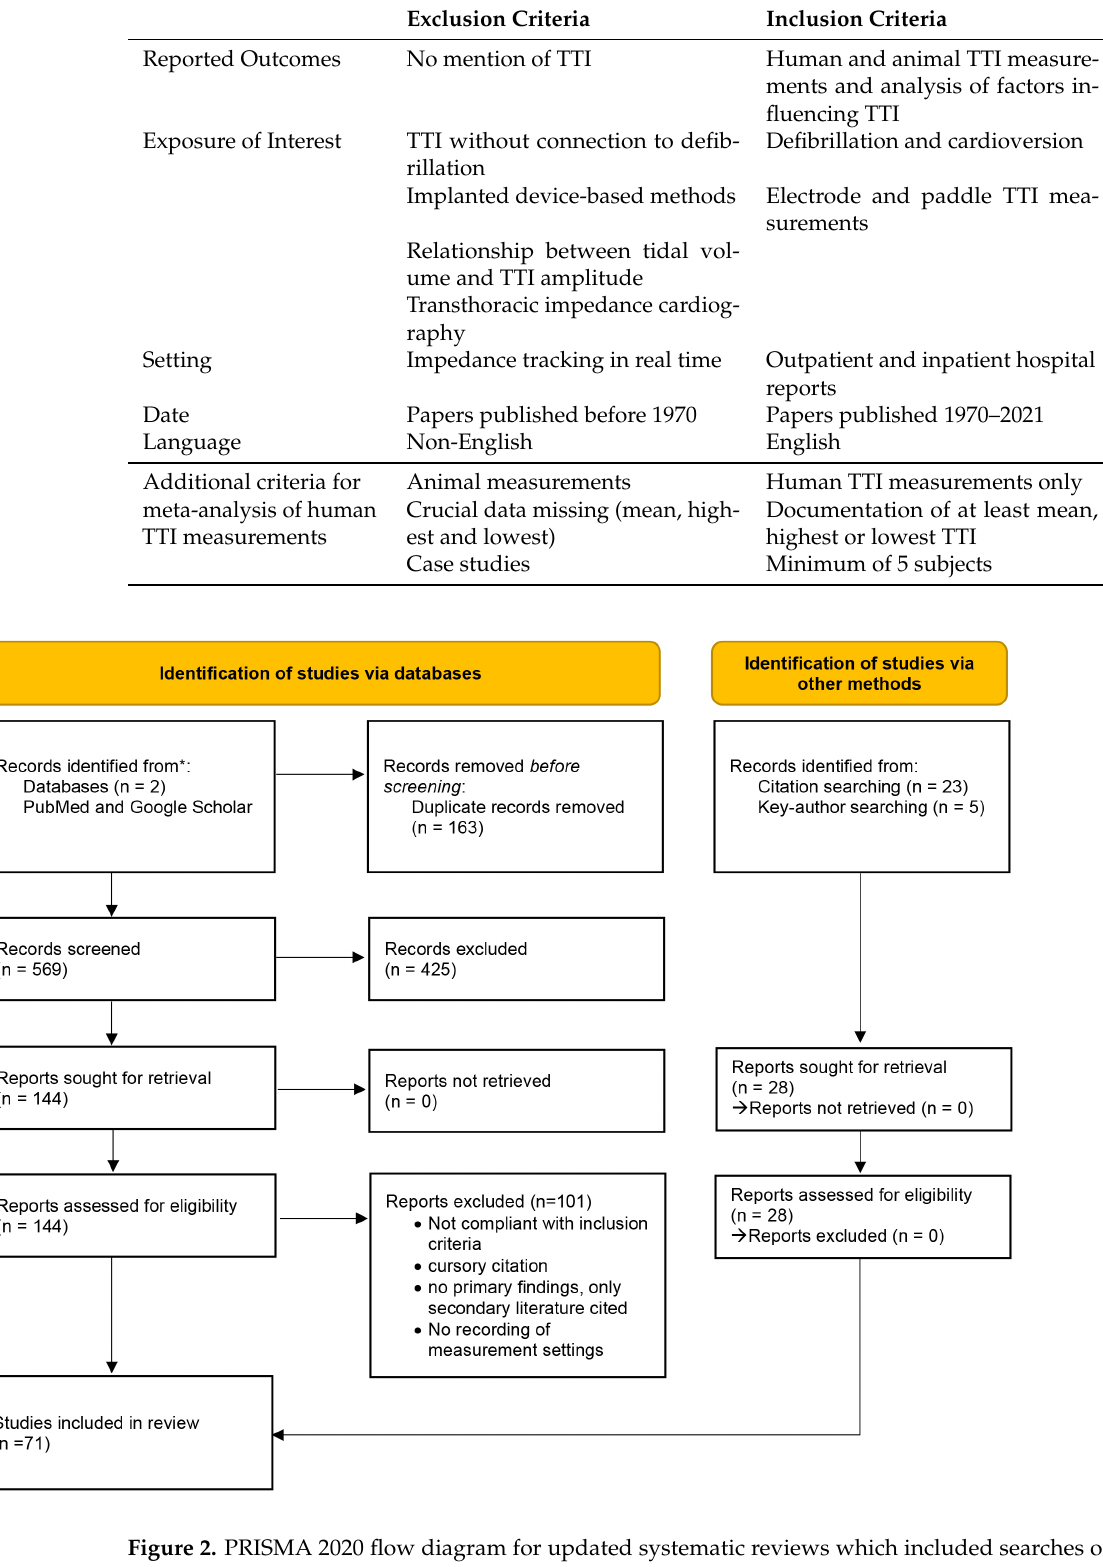
Figure 2. PRISMA 2020 flow diagram for updated systematic reviews which included searches of databases and other sources. See Page et al., 2021 [6]. For more information, visit: http://www. prisma-statement.org/ (accessed on 15 February 2022 )